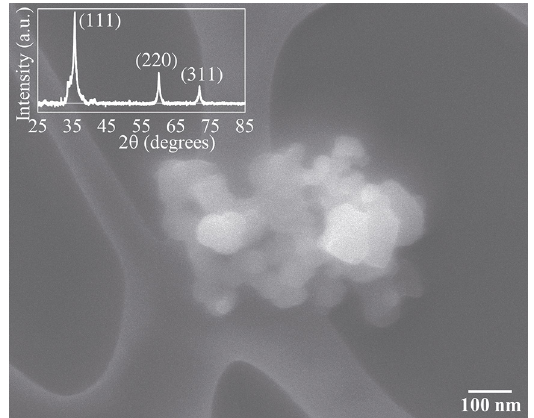
Figure 1: SEM micrographs of the SiC nanoparticles evidencing the particle diameter lower 100